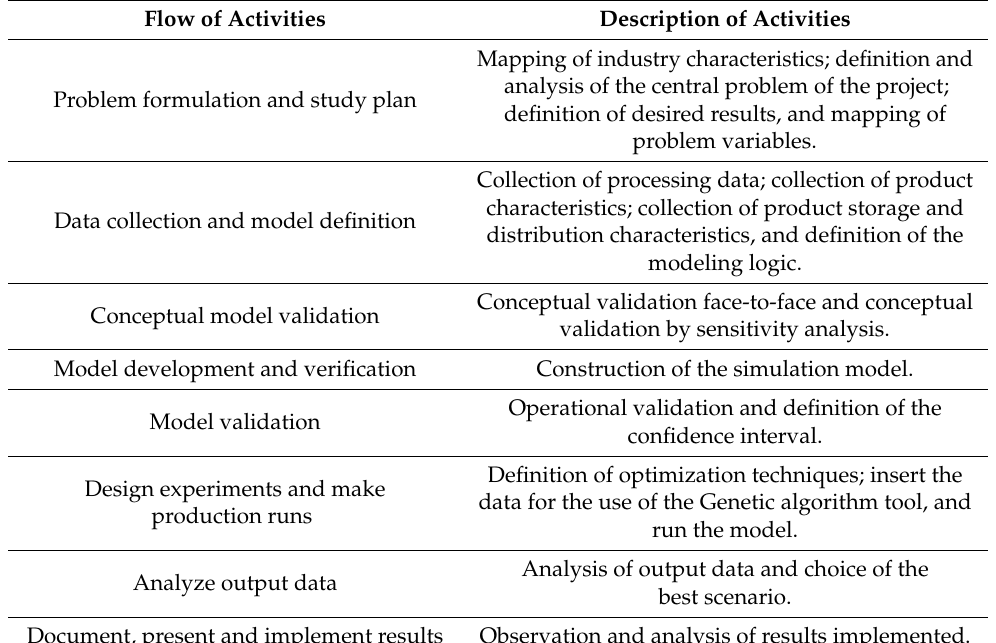
Table 1. Steps for simulation model